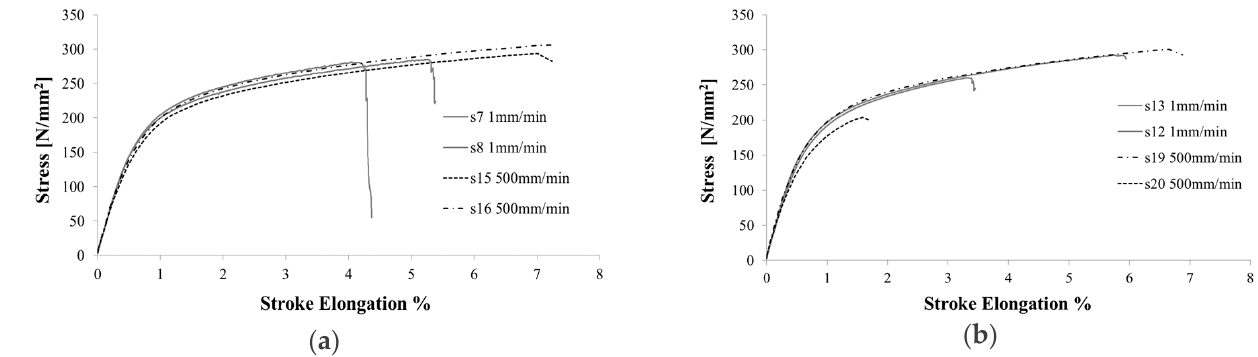
Figure 10. Comparison of Tensile Results at Different Stroke Speeds ( a ) A3.1 specimens ( b ) A3.3 specimens.